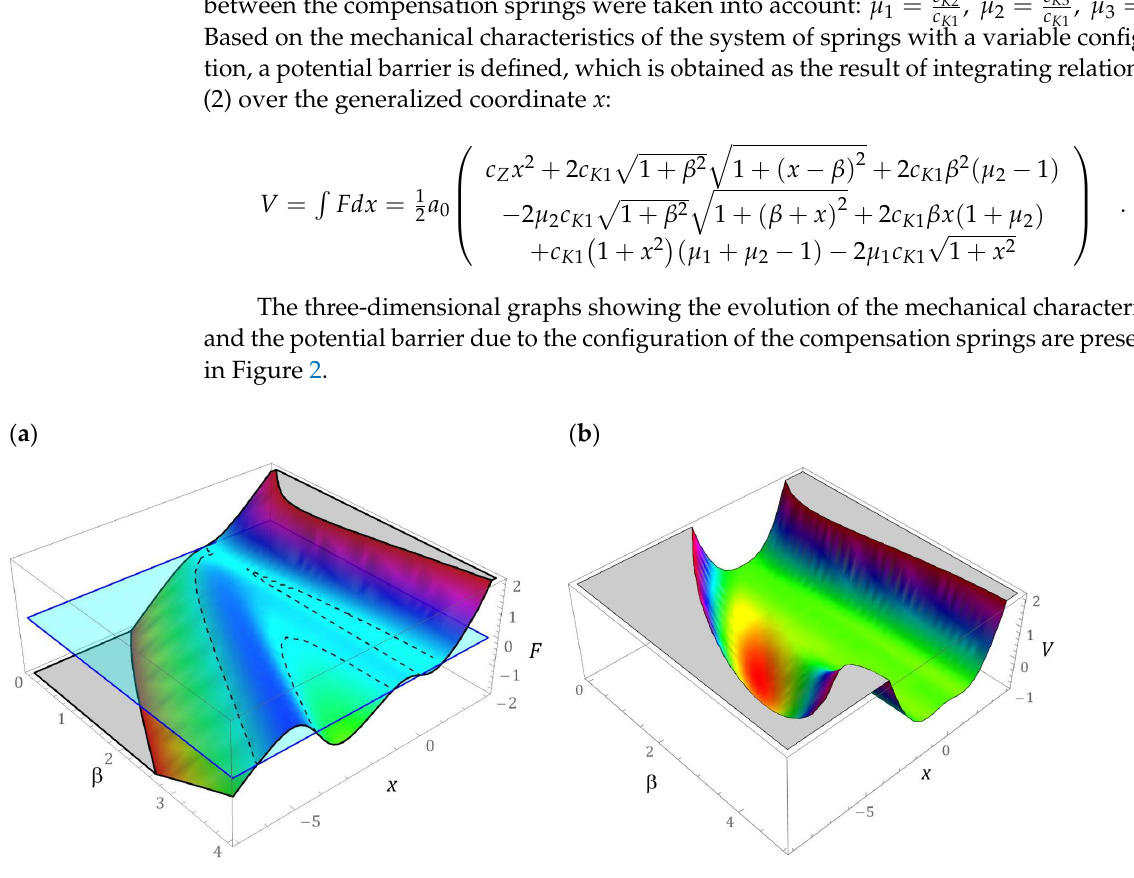
Figure 2. Three-dimensional images: ( a ) mechanical characteristics (restore force, F ), ( b ) potential barrier, V versus tip mass displacement, x , and the geometrical parameter, β .